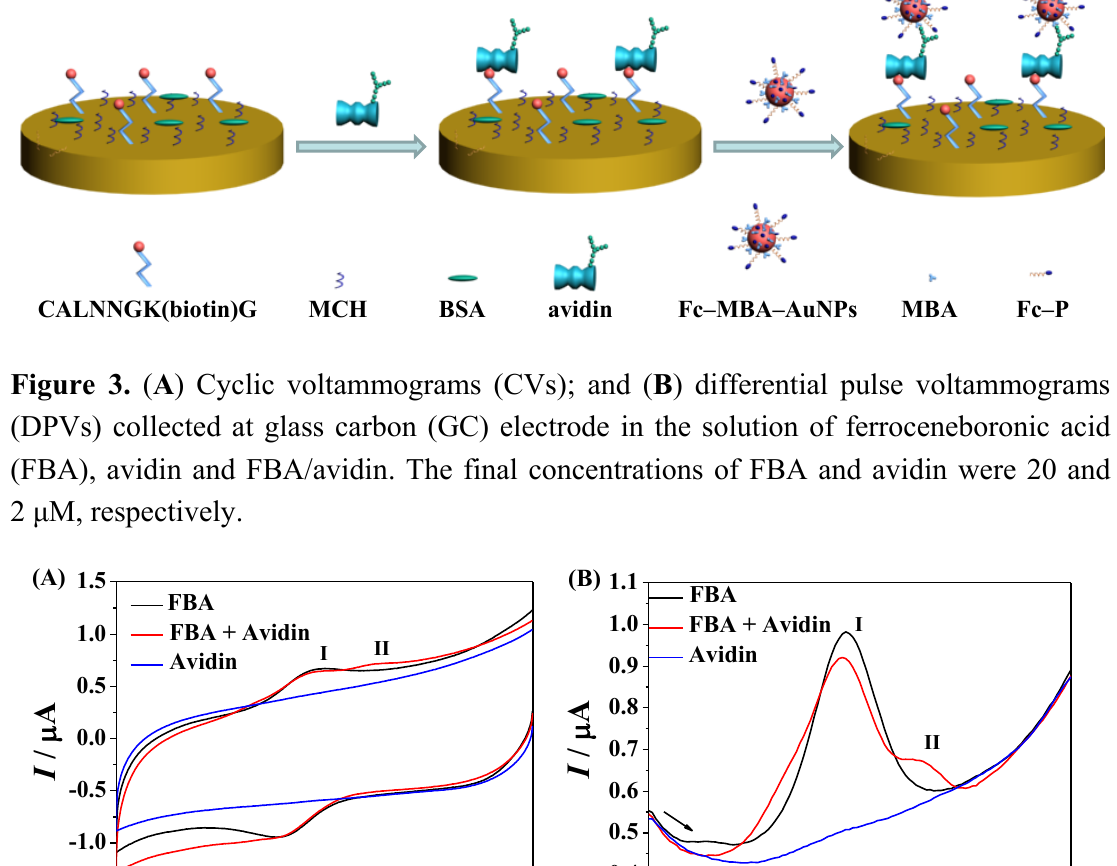
Figure 2. Schematic illustration for avidin detection using bifunctional Fc–MBA–AuNPs.